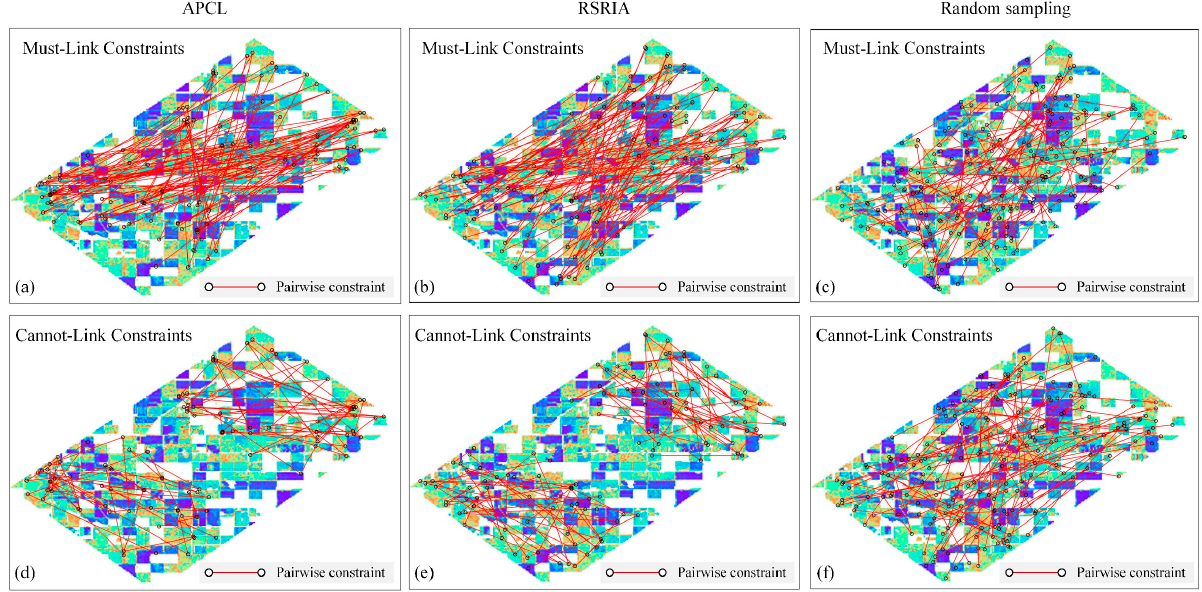
Figure 6. Distribution of the pairwise constraints, where the background is the heatmap of the samples’ silhouette coefficients: ( a ) MLCs of APCL; ( b ) MLCs of RSRIA; ( c ) MLCs of random sampling; ( d ) CLCs of APCL; ( e ) CLCs of RSRIA; ( f ) CLCs of random sampling.